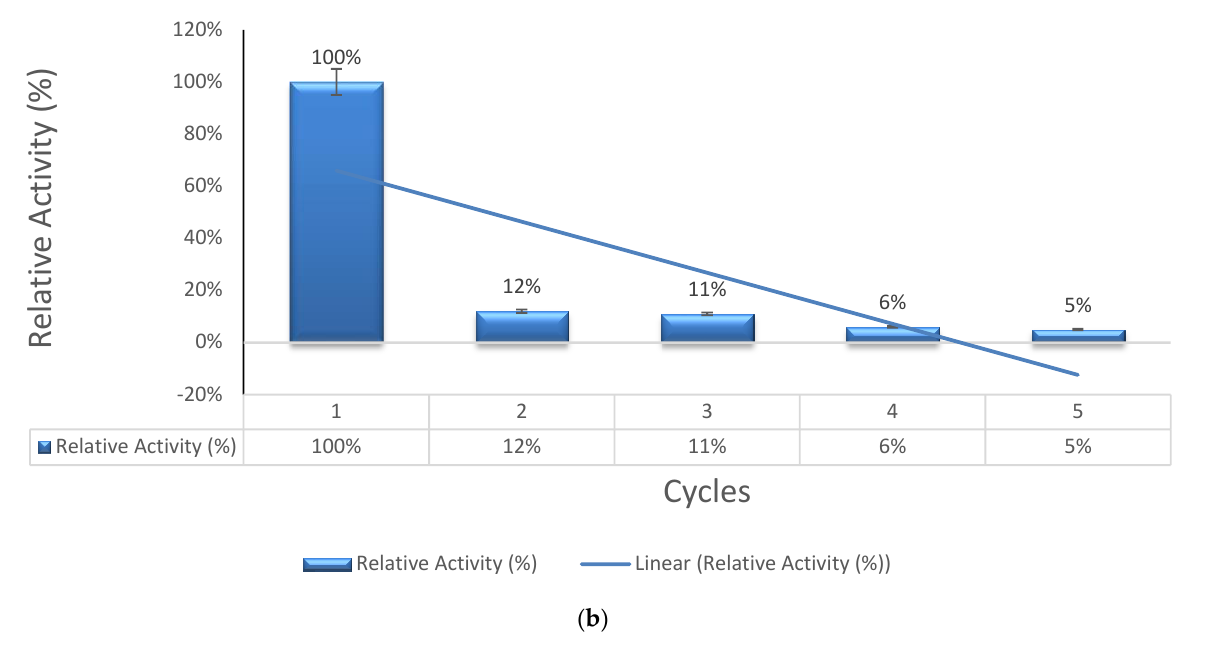
Figure 6. Operational stability of the immobilized lipase by PA ( a ) and CB ( b ) on biochar .